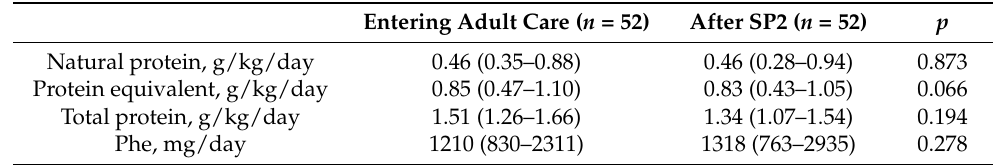
Table 4. Daily protein and Phe intakes ( n = 52). Results are expressed as median (P 25 –P 75 ). p < 0.05 was considered